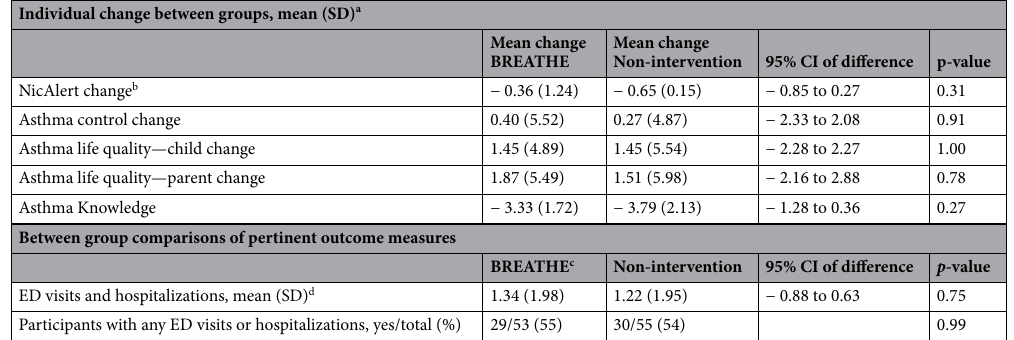
Individual change between groups, mean (SD) a